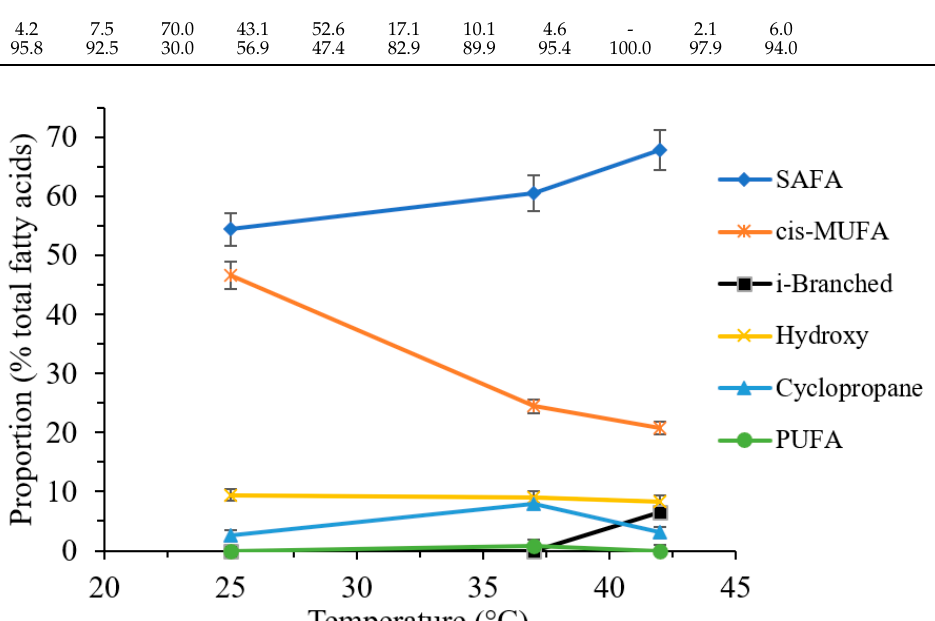
Figure 3. Influence of growth temperature on the mean proportion of fatty acid classes in bacteria ( P. aeruginosa PAO1, P. aeruginosa ATCC 27853, P. putida , and P. aeruginosa polyresistant) cultivated at 25, 37 and 42 °C on agar cultivation media and on the first day of incubation (mean ± SD; n = 3). The optimized experimental conditions are described in Materials and Methods. Table 3. Fatty acid methyl ester presence in samples from P. aeruginosa PAO1, P. aeruginosa ATCC 27853, P. putida , and P. aeruginosa polyresistant bacteria based on the percentile peak area. The bacteria were cultivated at 25 °C, 37 °C and 42 °C on agar media. Fatty acids were extracted one day following inoculation. The relative standard deviation is less than 2%. Experiments are made in triplicates.